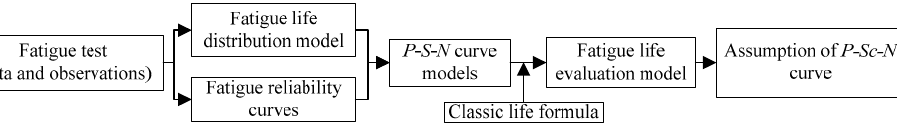
Figure 1. The structure of the research on proposed fatigue reliability.